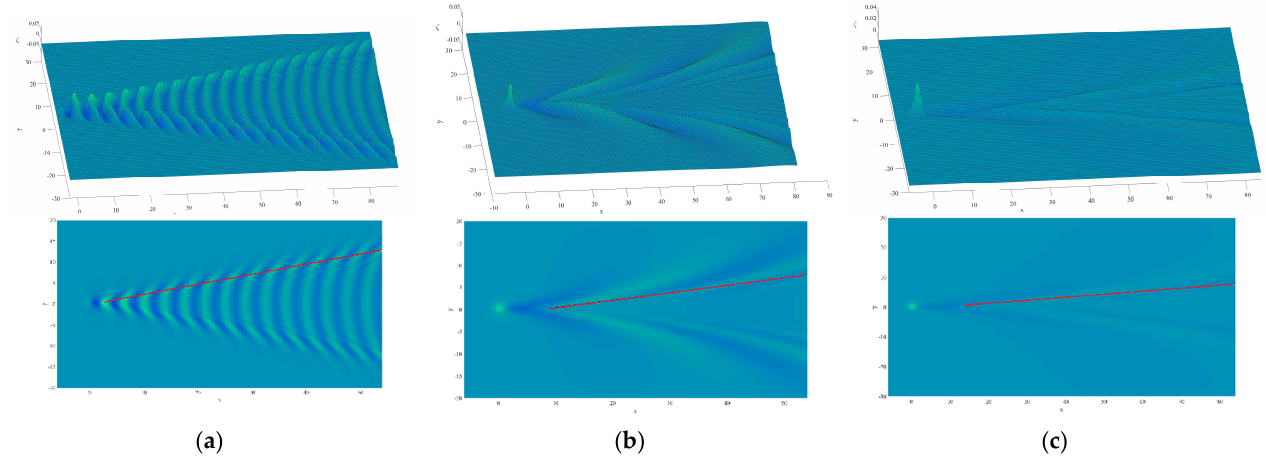
Figure 6. Perspectives and plans view of the free surfaces past Ranking source, computed on a 181 × 61 mesh with ∆𝑥′ = 0.3, ∆𝑦′ = 0.3 , for the cases 𝜇′ = 0.4 : ( a ) 𝐹′ = 0.7, ( b ) 𝐹′ = 2.5, ( c ) 𝐹′ = 5.0 . The top three free surface patterns are the perspectives and the bottom three free surface patterns are the plans. The red line marks the edge of the wake angle in each plan view.